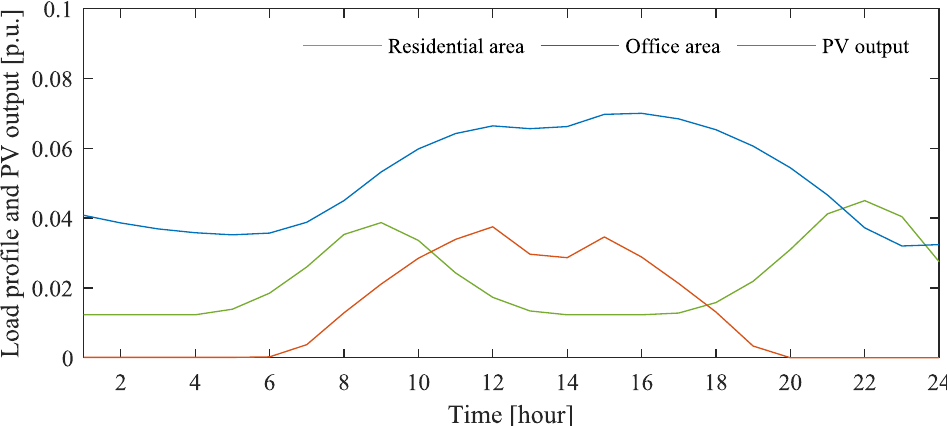
Figure 3. Load profile of each area and PV output; the load profiles is extended as three-phase unbalanced loads by decreasing 20% in phase b and increasing 20% in phase c . PV is installed only in phase a